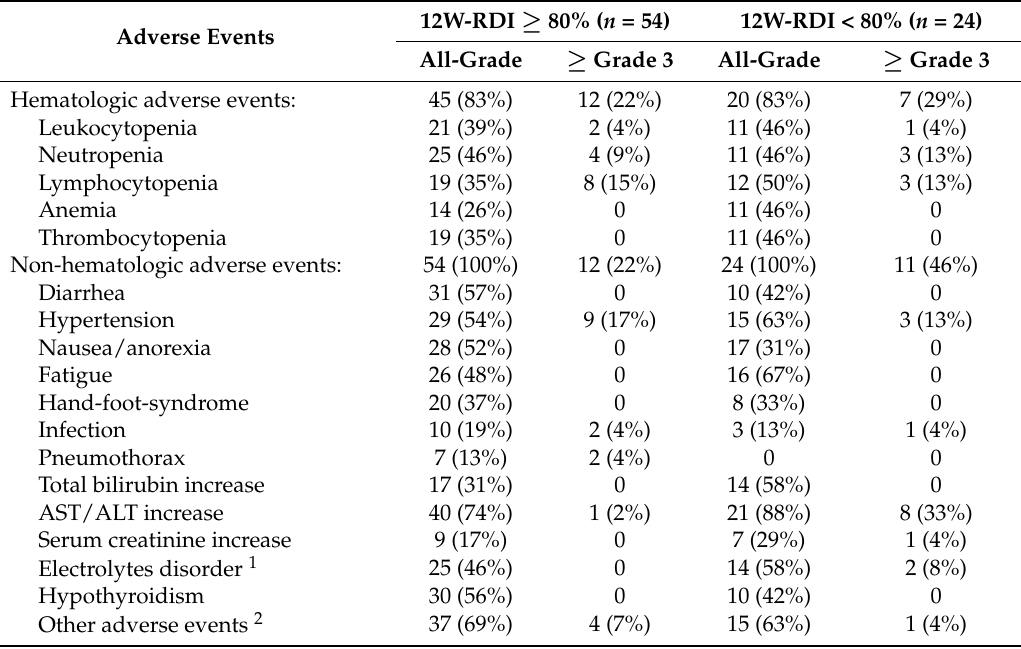
Table 2. Adverse events in the pazopanib responders.